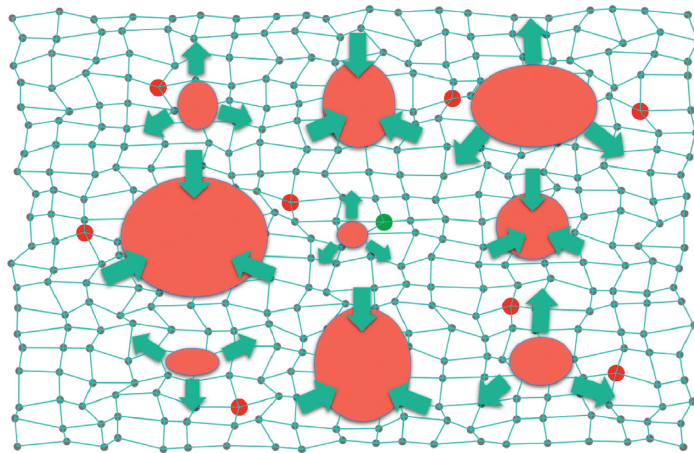
Figure 7: The schematic diagram of evolutionary dynamics for congestion areas ( N � 400, n � 8). Table 2: The optimized results of FRSA and GA in different dy- namic networks.